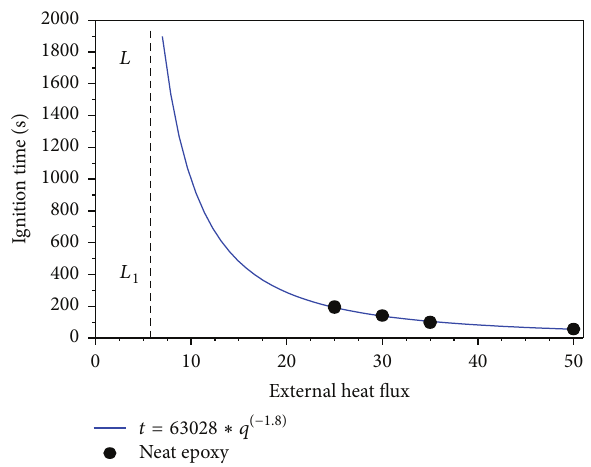
Figure 9: Critical heat flux of neat epoxy-0 wt.% EG composite samples.